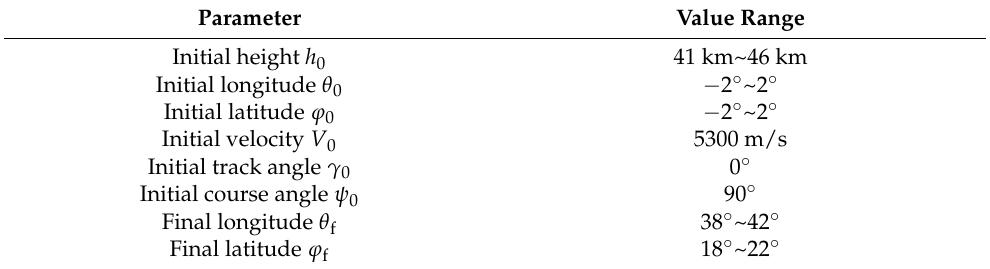
Table 1. Initial and termination conditions.